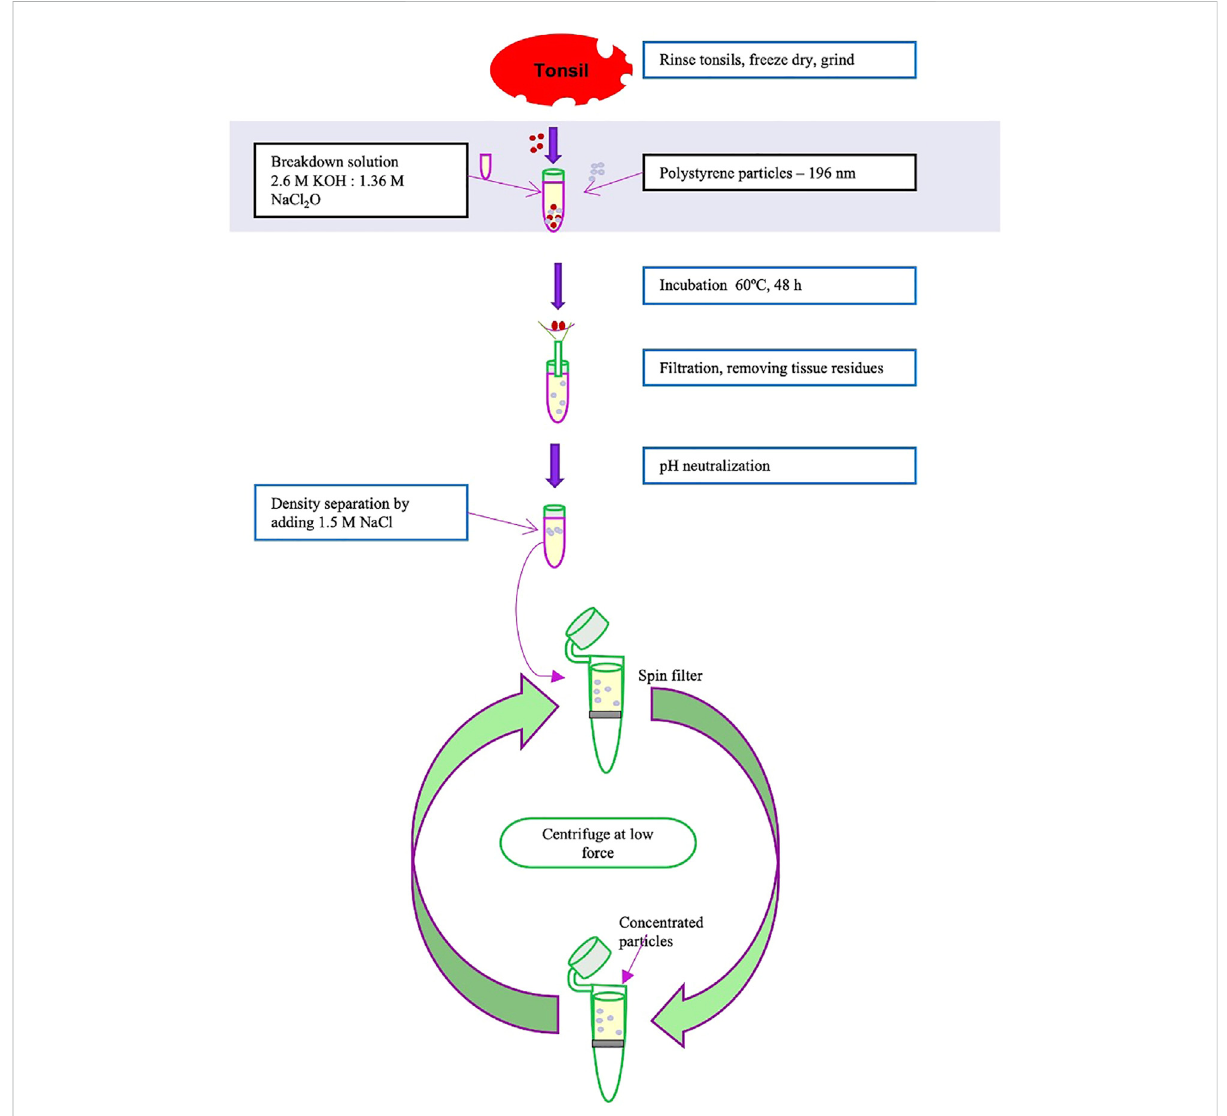
tonsillectomy, were broken down by freeze drying followed by grinding. Polystyrene particles with a nominal diameter of